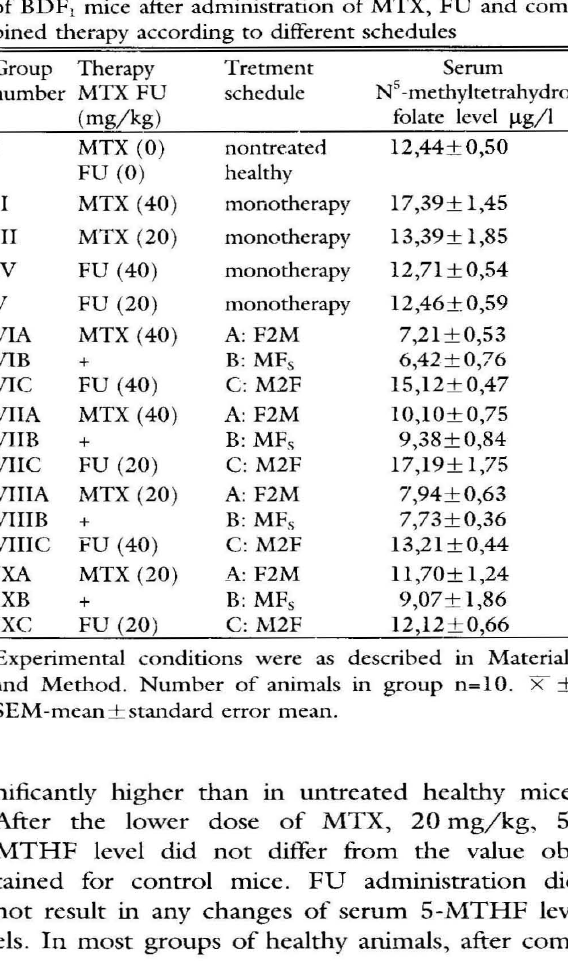
Table 8. Statistically significant differences between